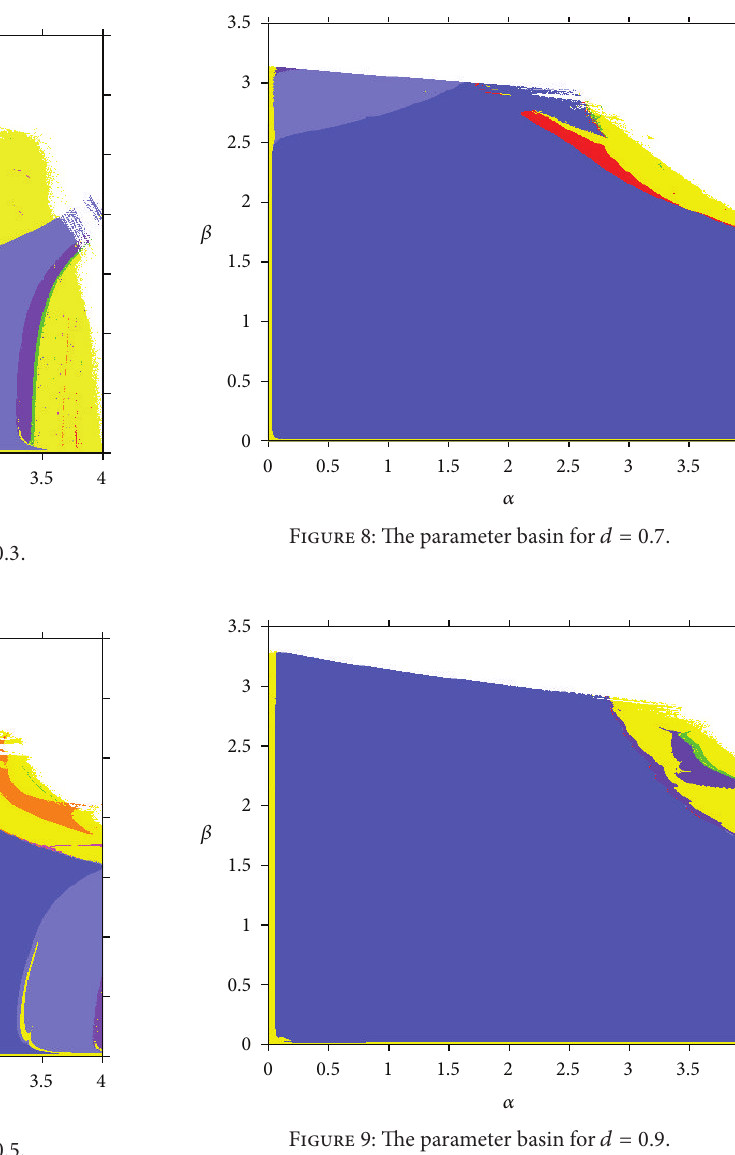
Figure 7: The parameter basin for 𝑑 = 0.5 .